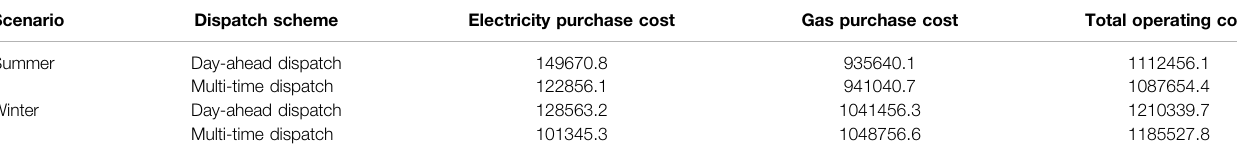
TABLE 5 | Comparison of operating costs under different dispatch